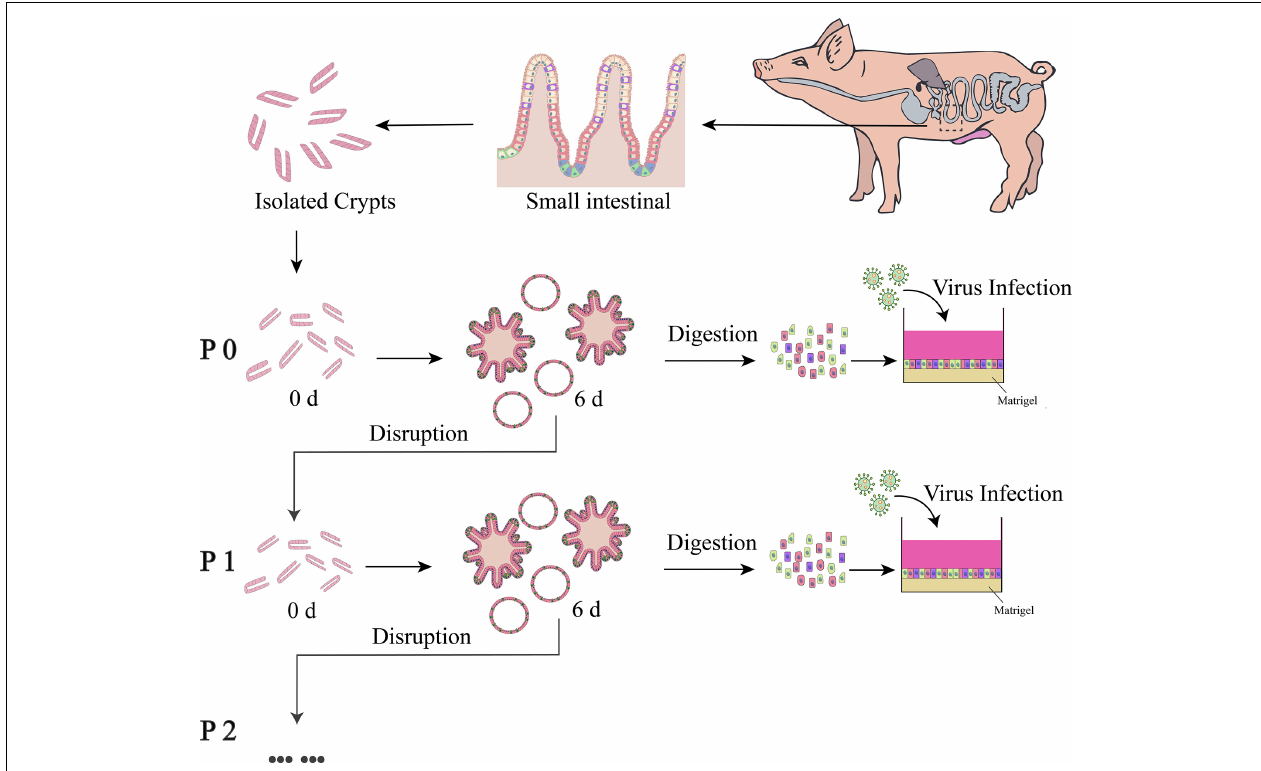
FIGURE 1 | Schematic diagram of culture, passaging and usage of enteroids. The enteroids were cultured for about 6 days and then disrupted by scraping and repeated pipetting. The dispersed enteroids were used for passaging or preparation of a single-cell mixture to be seeded in a 96-well plate pre-coated with 2.5%